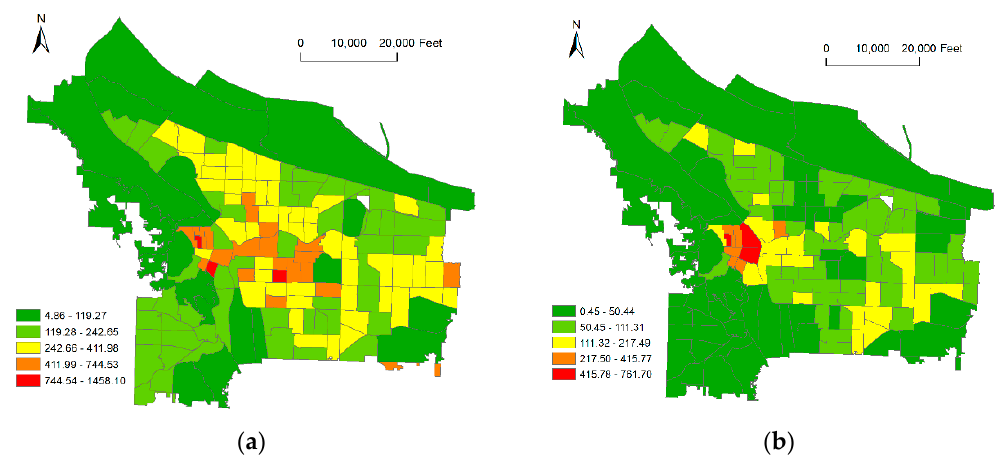
Figure 3. Density of ( a ) population and ( b ) crime cases of per square kilometers by census tracts. The U.S. Census Bureau divides each state into counties, each county into a number of census tracts, each census tract into a number of census block groups, and each block group into a number of census blocks.